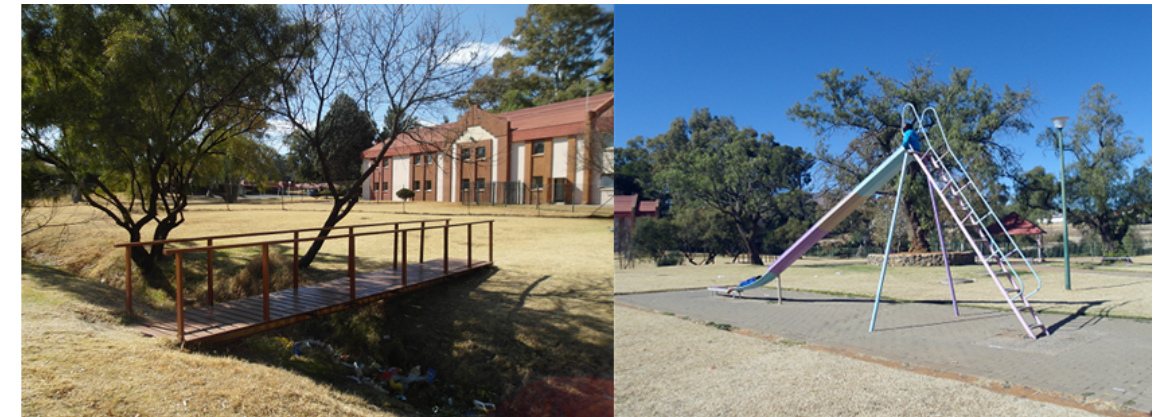
Figure 8. Waste in the gully (left); unsupervised children playing barefoot (right). Source: photographs by author.